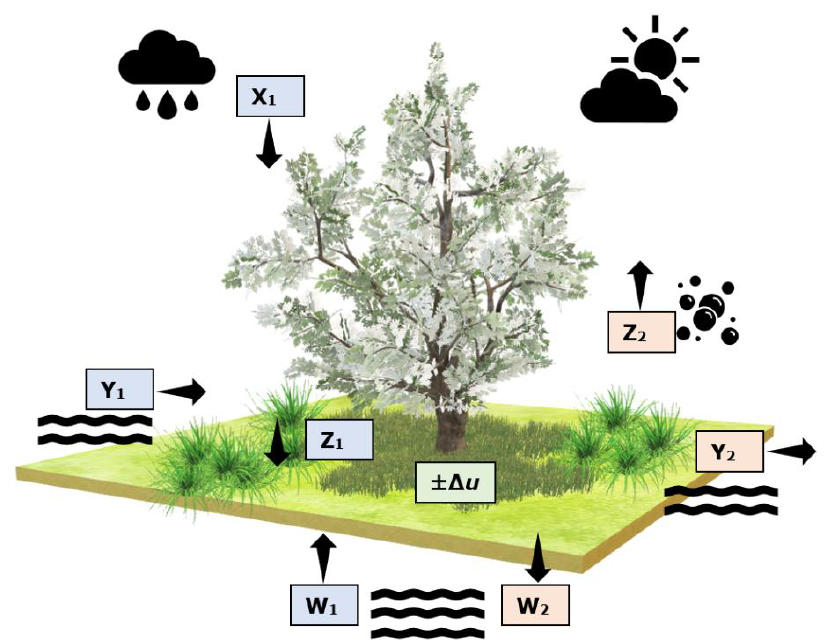
Figure 3. Scheme of the water balance equation. Black arrows show the flows direction.